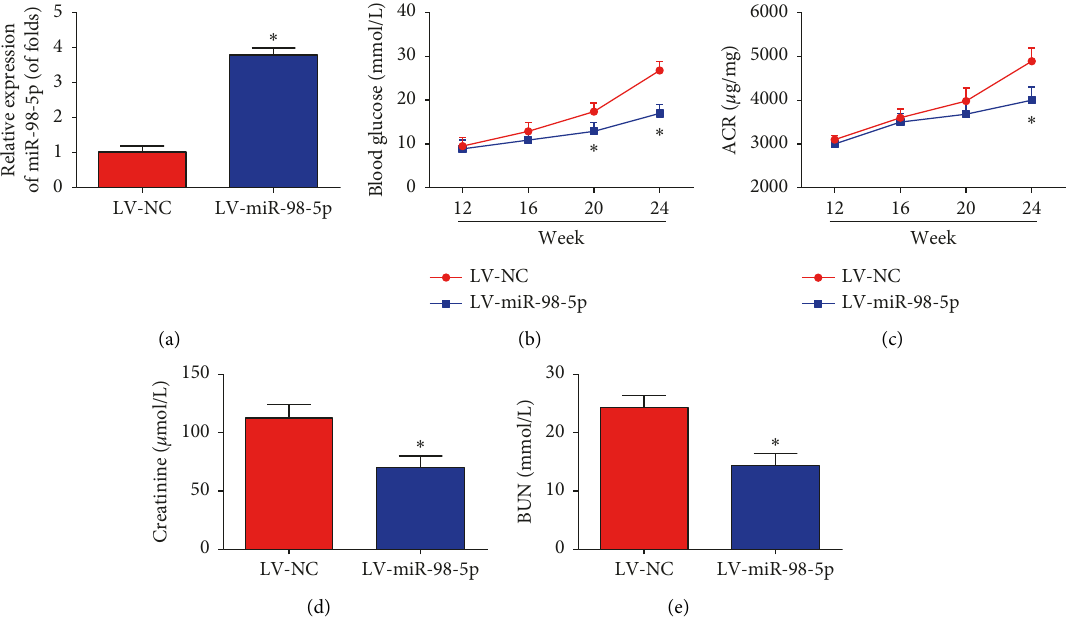
8 for each group. Data are (cid:31) P 0 . 05. SD of at least triplicate experiments. ∗ ±